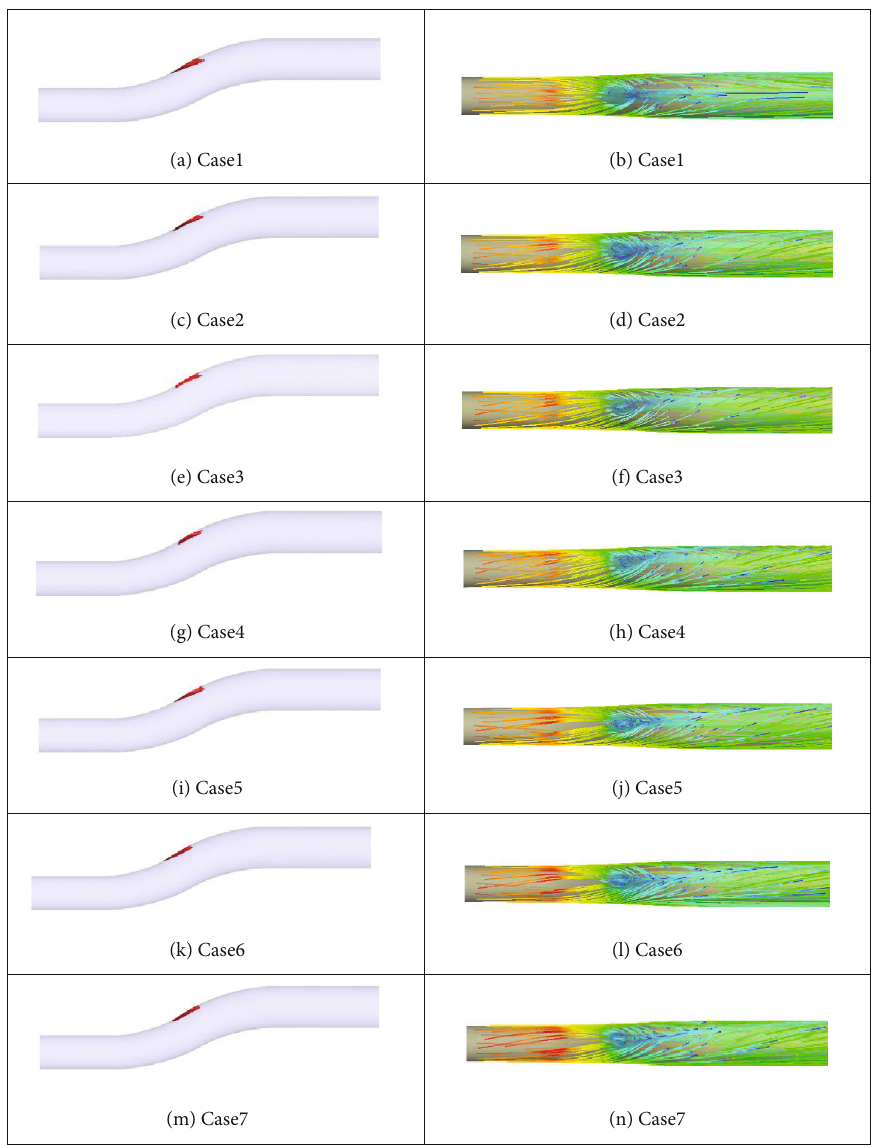
Figure 12: Separation bubble and the limit pathline for wall.